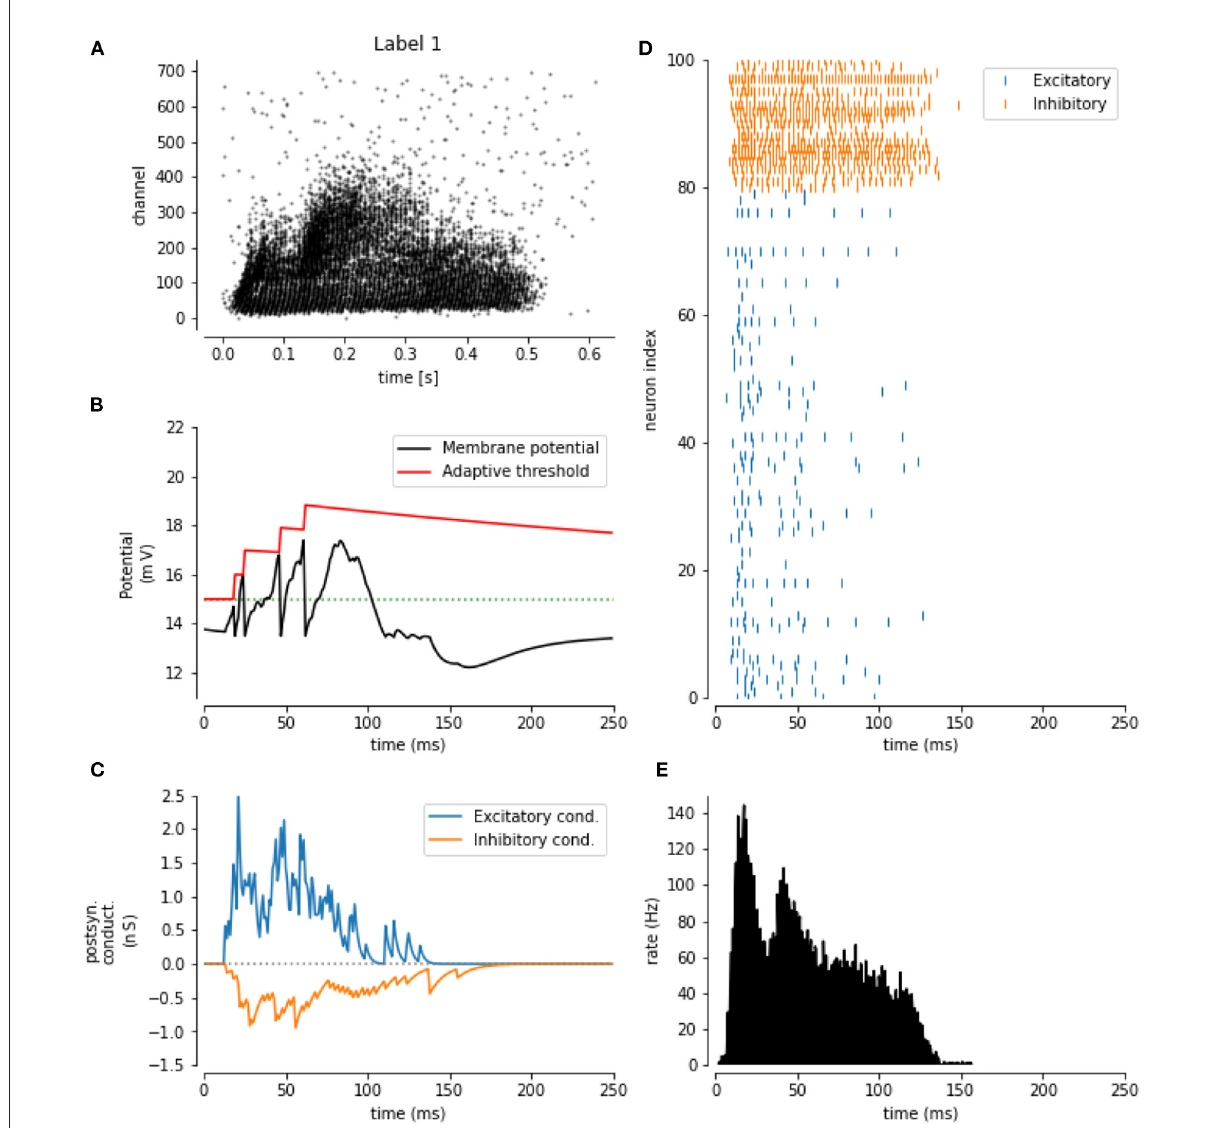
FIGURE4 Impact of the spike-frequency adaptation: (A) Sample from the SHD training data set. (B) The evolution of the membrane potential (black) and the adaptive threshold (red) over time for one excitatory neuron. (C) The evolution is the excitatory (blue) and inhibitory (orange) conductance over time for the same neuron. (D) Output spikes for 100 sample neurons. (E) Momentary spike rate for the whole LSM for the SHD